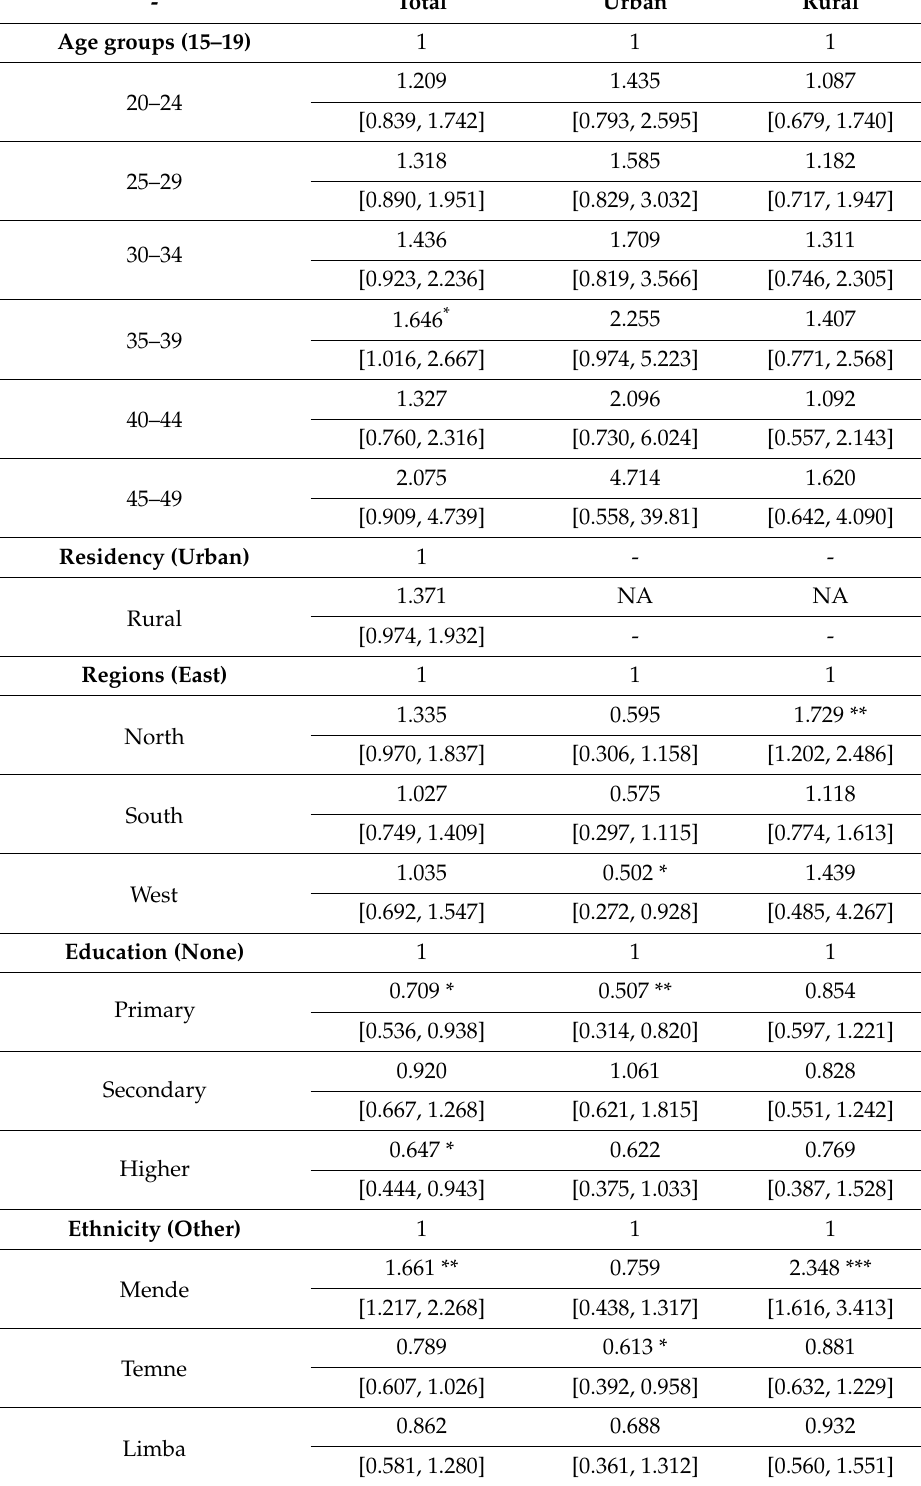
Table 2. Predictors of taking IPTp-SP among urban and rural women in Sierra Leone (bivariate